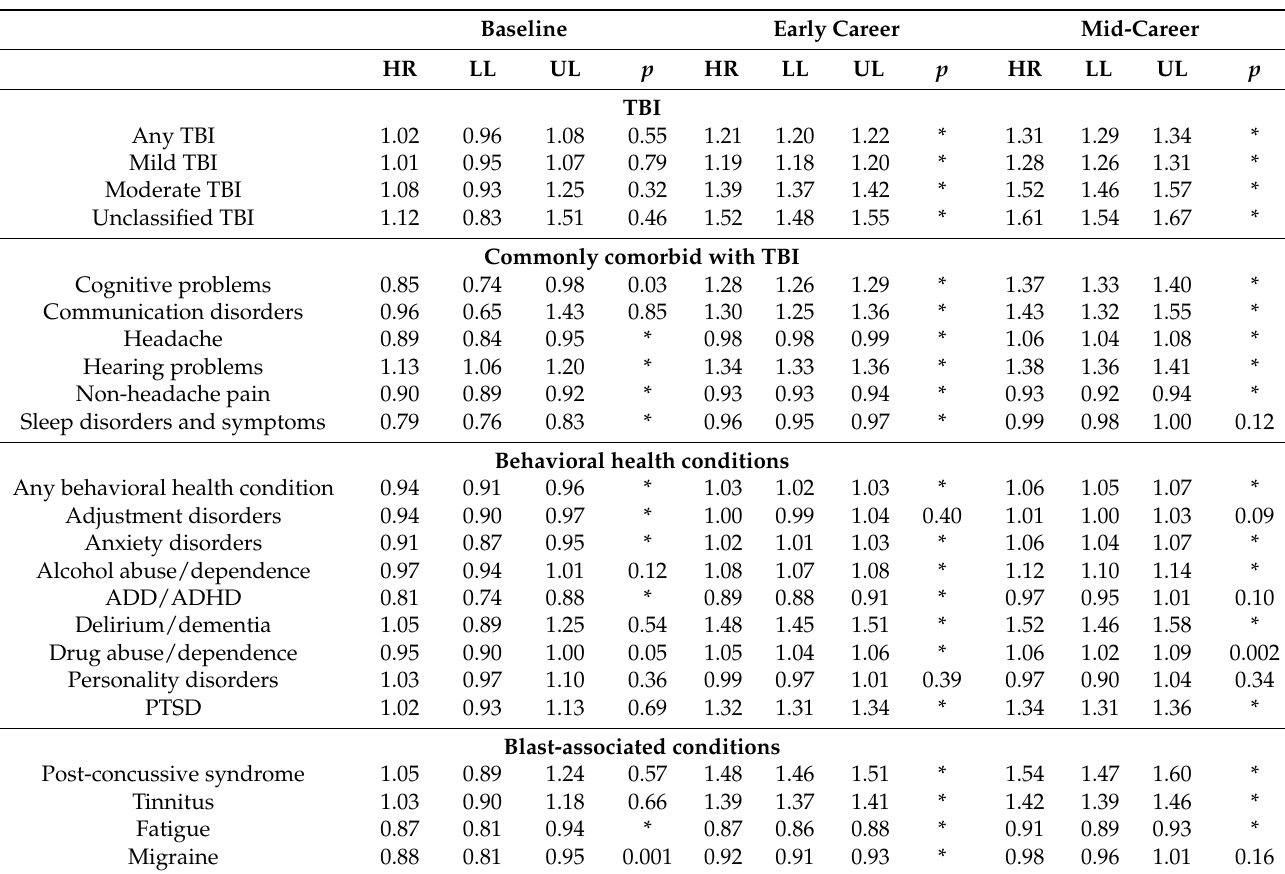
Table 3. Decomposition of significant occupational risk by time in service interactions a